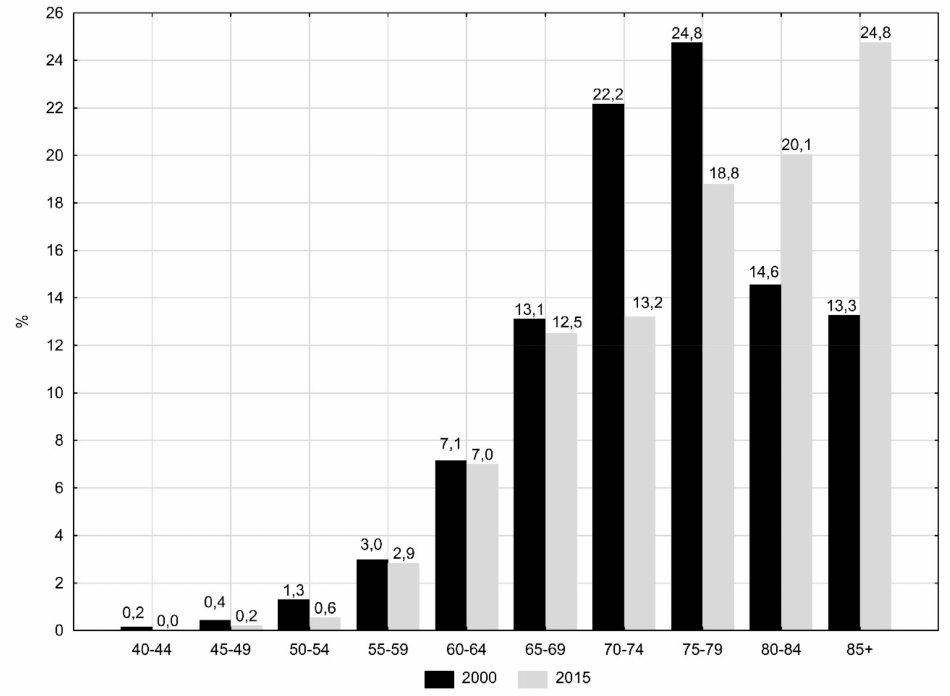
Figure 1. Percentage of deaths due to prostate cancer by age groups in 2000 and 2015 in Poland.